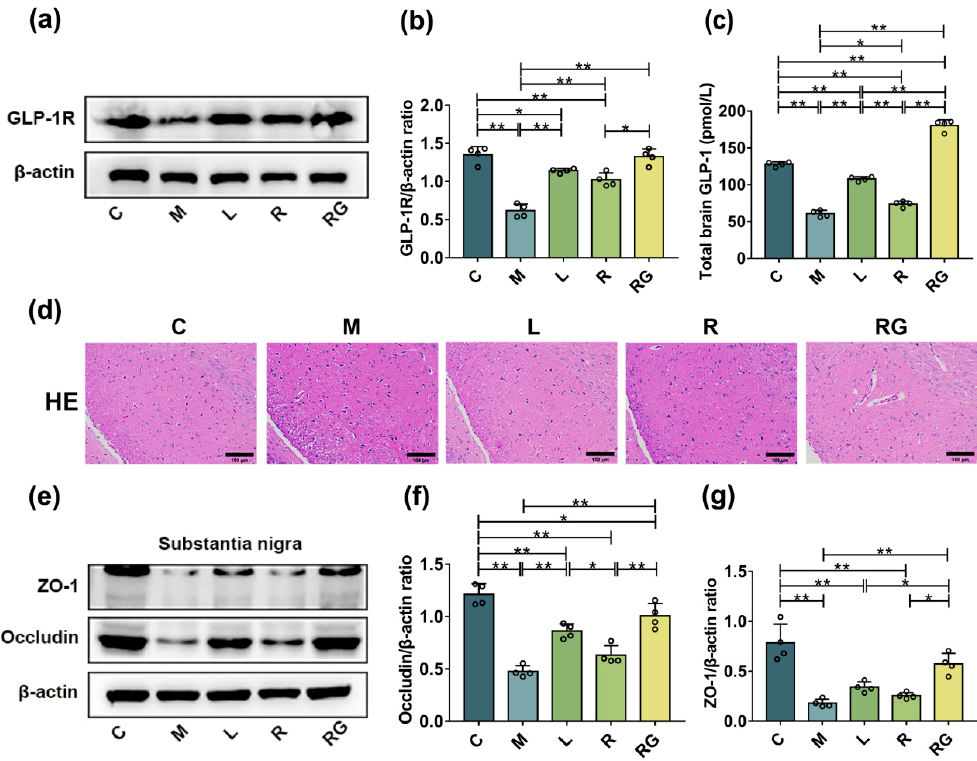
Figure 3. L. lactis MG1363-pMG36e-GLP-1 increased GLP-1 and potentially improved the integrity of the BBB in PD model mice. ( a ) Western blotting of GLP-1R and β -actin in the SN. ( b ) Relative quantification of GLP-1R protein levels adjusted to internal reference β -actin ( n = 4). ( c ) GLP-1 concentrations in the SN as measured by ELISA ( n = 4). ( d ) Images of H and E staining in the SN (scale bar = 100 µ m). ( e ) Western blotting of ZO-1, occludin, and β -actin in the SN. ( f , g ) Relative quantification of ZO-1 and occludin protein levels adjusted to internal reference β -actin ( n = 4). * p < 0.05 and ** p <